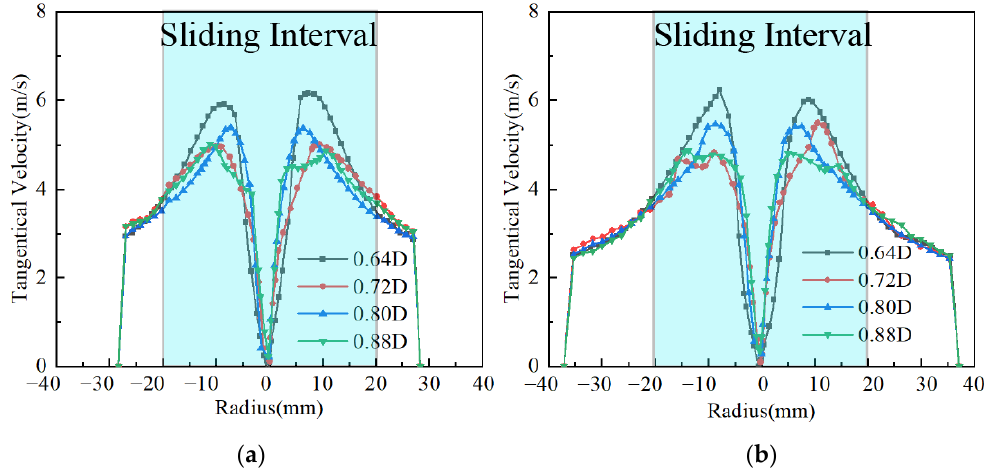
Figure 7. Influence of internal overflow pipe diameter on tangential velocity. ( a ) z = 150 mm ( b ) z = 200 mm.